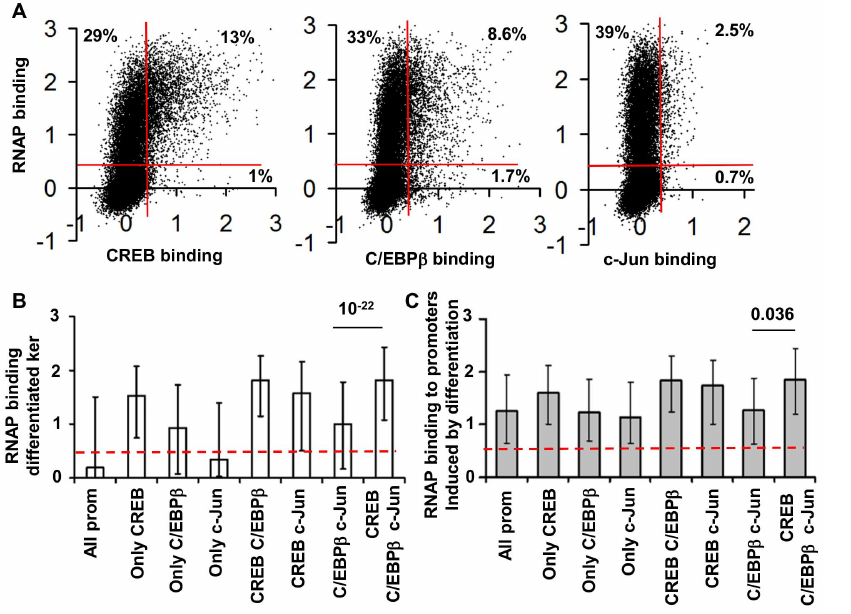
Figure 4. Colocalization of C/EBP b and c-Jun with CREB is associated with high probability of RNAP binding in all promoters and promoters induced by differentiation. A. Scatter plots of transcription factors and RNAP binding show that 95% of promoters bound by CREB, 82% of C/EBP b and 62% of c-Jun bound promoters are also bound by RNAP. Lines are RNAP binding thresholds. B. RNAP binding percentiles (15%, 50% and 85%) in promoters bound by different combinations of transcription factors in differentiated keratinocytes. C. RNAP binding percentiles (15%, 50% and 85%) in promoters induced by differentiation and bound by different combinations of transcription factors. Numbers over the bars represent t-test values. Dotted lines are RNAP binding thresholds.